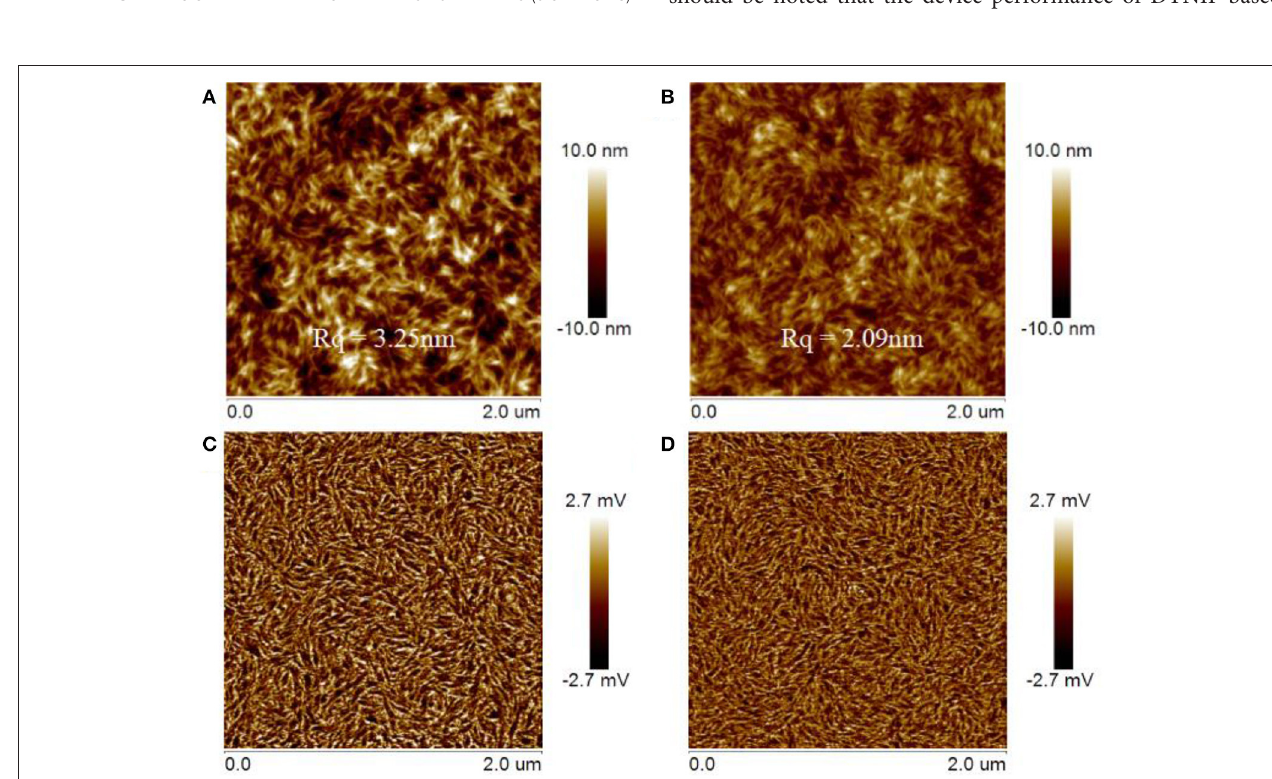
FIGURE 6 | Tapping-mode AFM topography images (A,B) and phase (C,D) images of the PBDB-T:DTNIF (A,C) and PBDB-T:DTNSF (B,D) films.